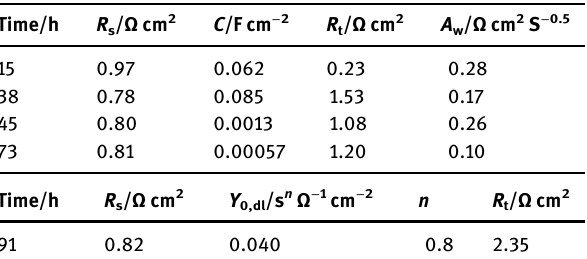
Table 4: EIS fi tting results of 316 stainless steel in ternary chloride molten salt